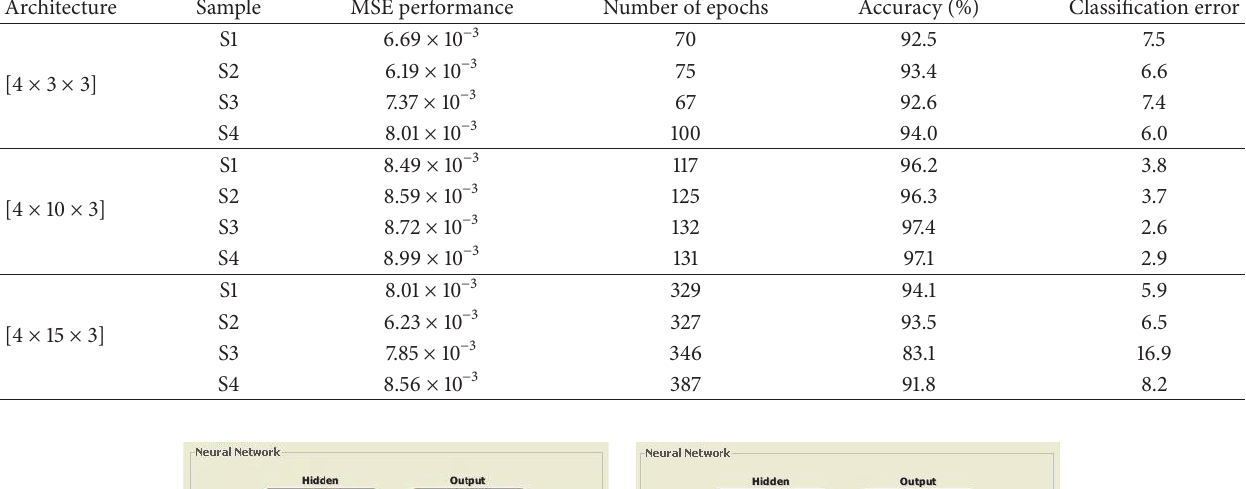
Table 5: Performance of different architectures for classification.